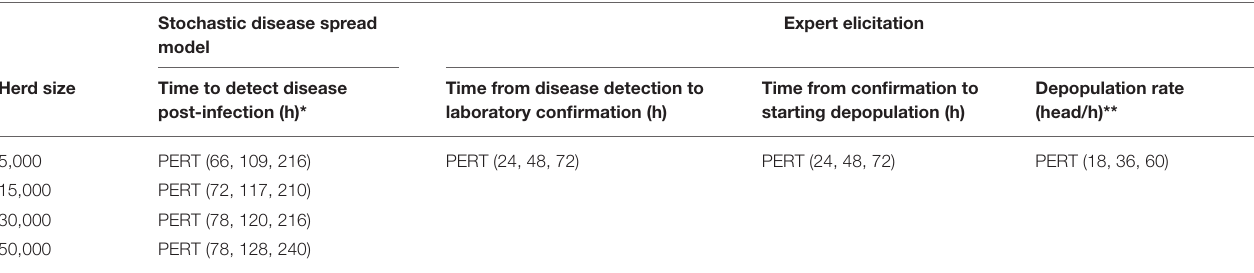
TABLE 4 | Input values to estimate timings for depopulation procedure in case of FMD outbreak in beef cattle premises. Stochastic disease spread model